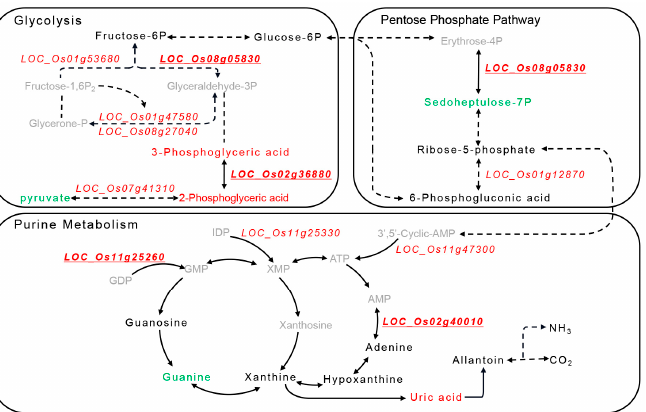
Figure 6. Coordinated changes of genes and the relative metabolites between G9 and G1 under LN conditions. The red/green indicated the expression levels of genes and/or the contents of metabolites were higher/lower in G9 than in G1; the black indicated no difference and the grey indicated not detected in the study. The genes with underline indicated the gene is located in introgressed regions. Fructose ‐ 6P, glucose ‐ 6P, pyruvate and sedoheptulose ‐ 7P were the abbreviations of the fructose 6 ‐ phosphate, glucose 6 ‐ phosphate, pyruvic acid and sedoheptulose 7 ‐ phosphate, respec ‐ tively.